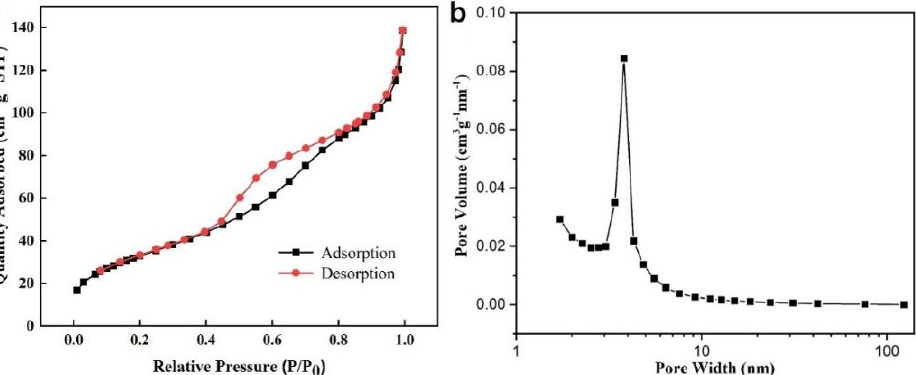
Figure 4. ( a ) N 2 adsorption – desorption isotherms and ( b ) pore size distribution for Ni-Pd/Fe 3 O 4 cat- alyst.